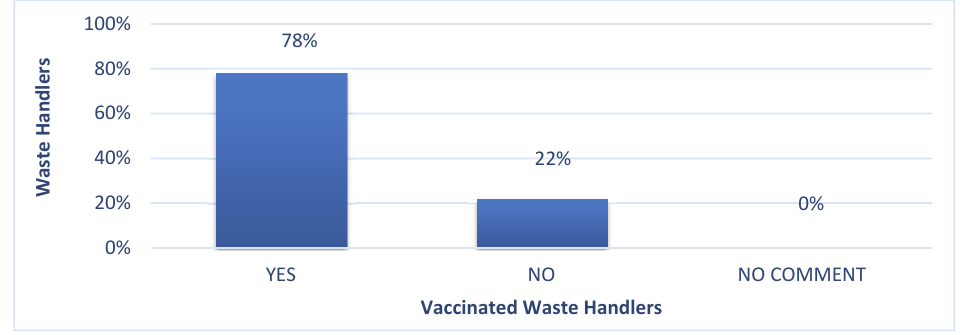
Fig. 9. Vaccination of waste management